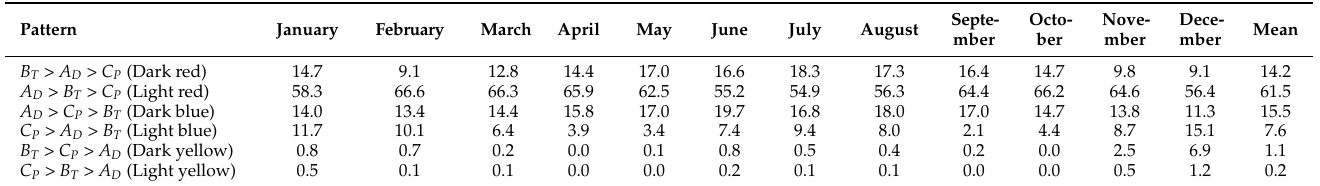
Table 1. The ratio (unit: %) of the number of the grid points with each of the six patterns to the number of the total grid points over the